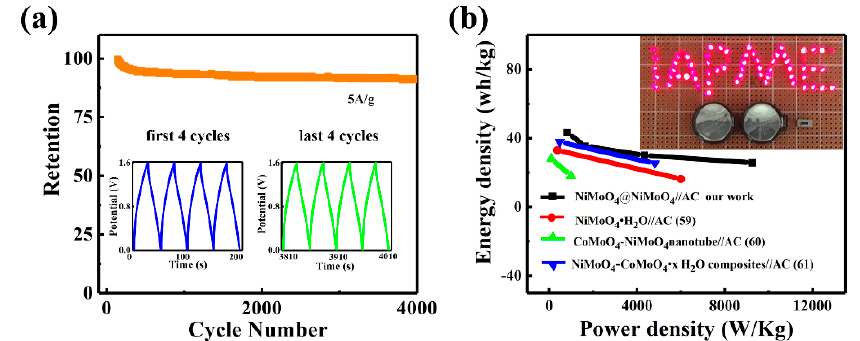
Figure 7. NiMoO 4 @NiMoO 4 // AC; ( a ) 4000 cycles cycling performance with the inset GCD plots of the first and last four circles; ( b ) the comparison of the Ragone plot with previous ASCs, and the inset picture shows two NiMoO 4 @NiMoO 4 // AC devices connected in series lighting up 64 red LEDs.